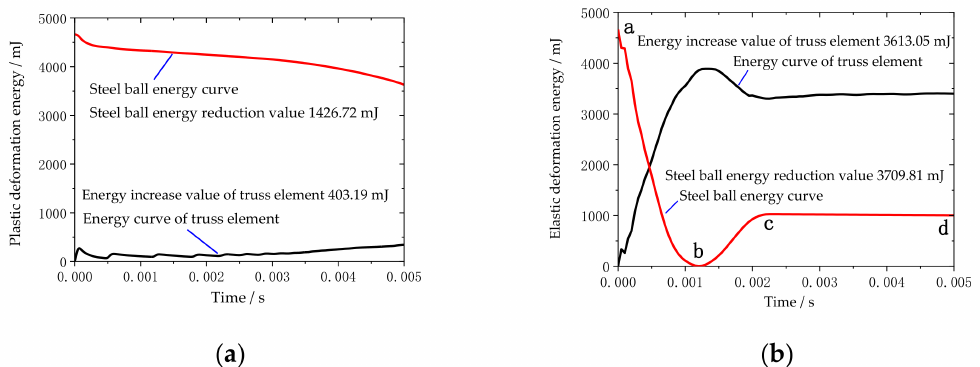
Figure 7. Law of energy change of truss beam structure: ( a ) Energy change under plastic deformation; ( b ) Energy change under elastic